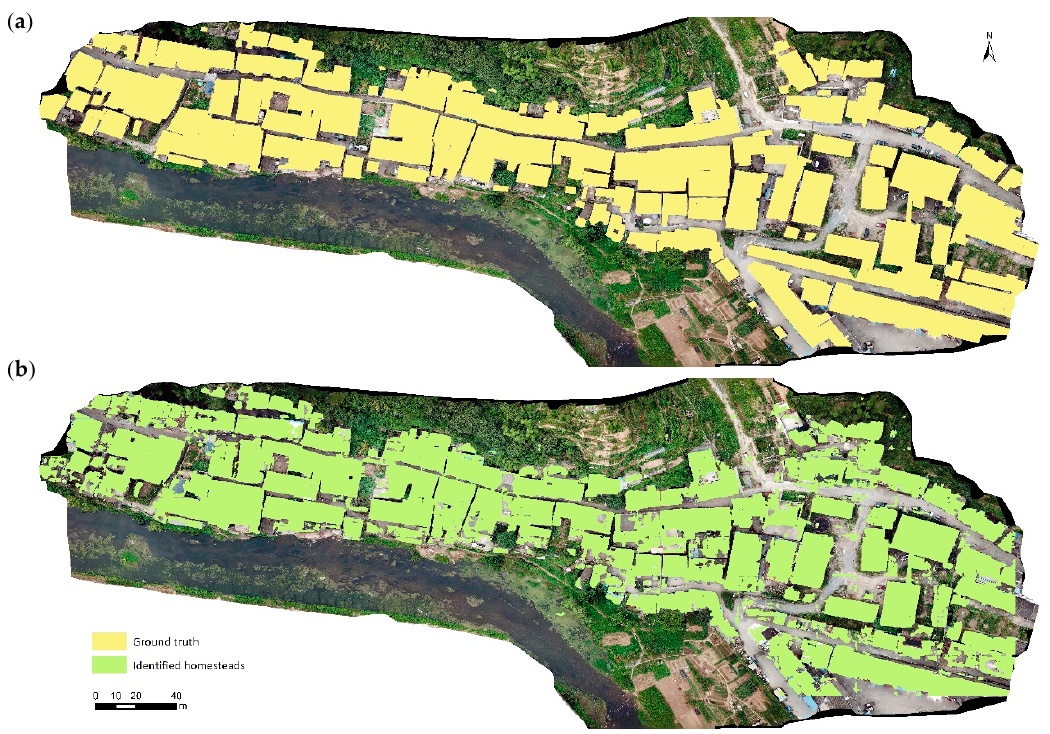
Figure 4. Village-level estimates of the areas and spatial distributions of rural homesteads. ( a ) Ground truth of homesteads, and ( b ) identification results based on the U-net algorithm.